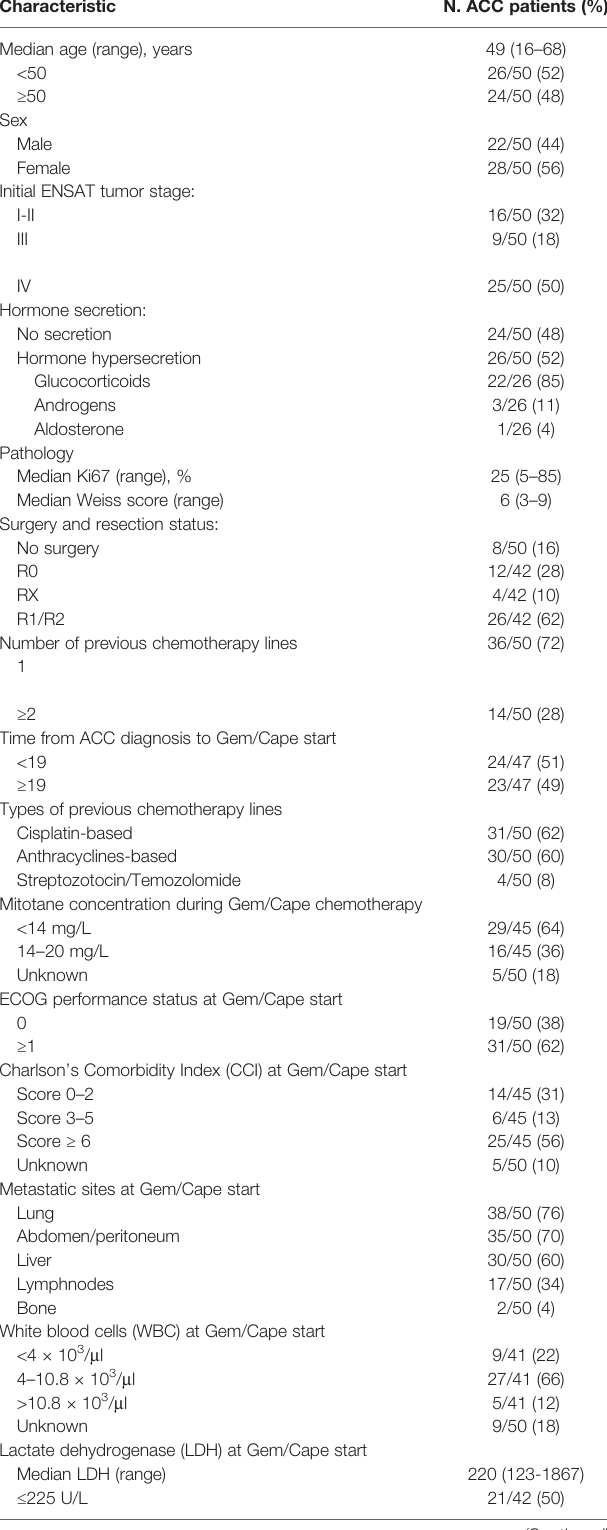
TABLE 1 | Patients clinical and pathological characteristics at initial diagnosis and at start of Gem/Cape chemotherapy.